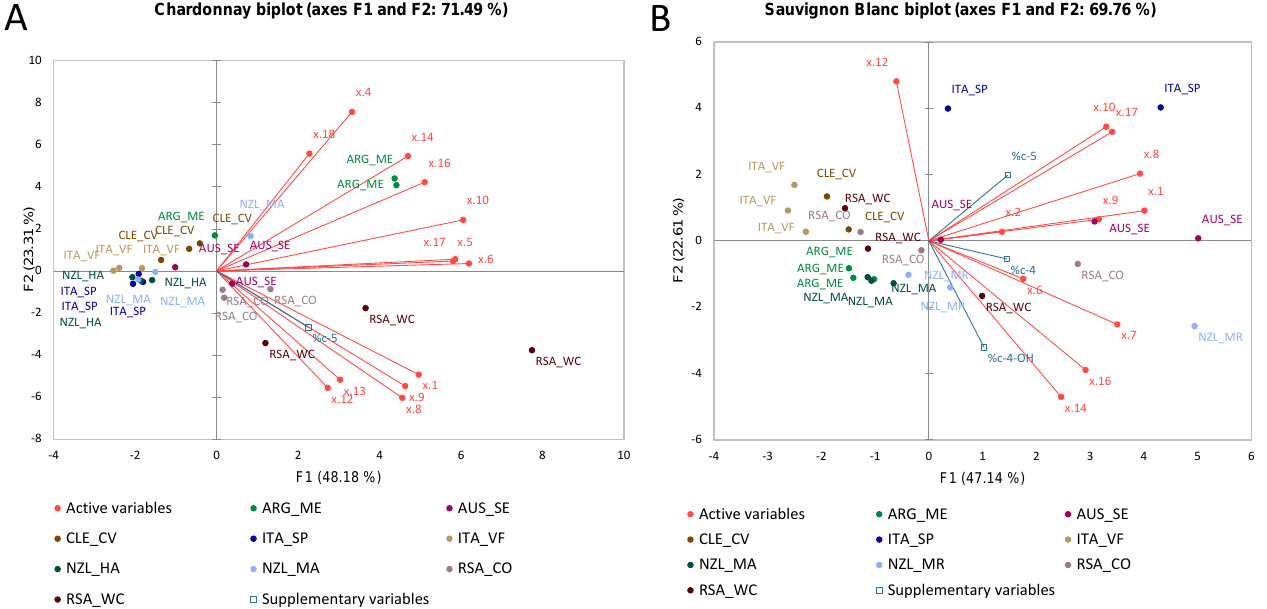
Figure 12. Biplot of PCA for the significant PAC for Chardonnay and Sauvignon Blanc wines. ( A ) Biplot PC1 vs. PC2, ( B ) Biplot PC2 vs.